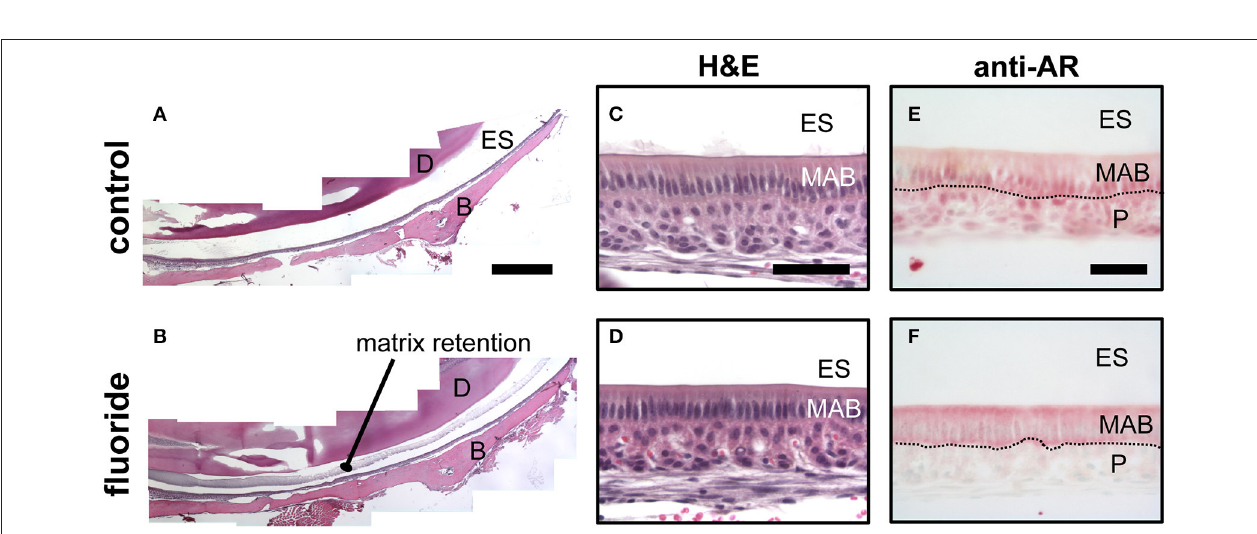
FIGURE 2 | Fluoride related change in the enamel matrix correlates with reduced AR nuclear translocation. (A–B) Hematoxylin and eosin-stained mandibular incisors from control (A) and fluorosed (B) mice. Retained enamel matrix protein is seen in the enamel space of fluorosed but not control mouse enamel. Composite scale bar 1mm. ES; enamel space, D; dentin, B; bone (C–D) Hematoxylin and eosin-stained maturation ameloblasts from control (C) and fluorosed (D) mice. Bar; 100 um (E–F) Maturation-stage ameloblasts immunostained for AR. Control mice have positive AR immunostaining (red color) in the nucleus of maturation ameloblasts (MAB) and papillary layer cells (P). (E) . In fluorosed mice, AR immunostaining is mainly seen in the cytoplasm of ameloblasts and absent on the nuclei. Papillary layer cells are negative for AR immunostaining (F) . ES; enamel space, Bar; 50 µ m.